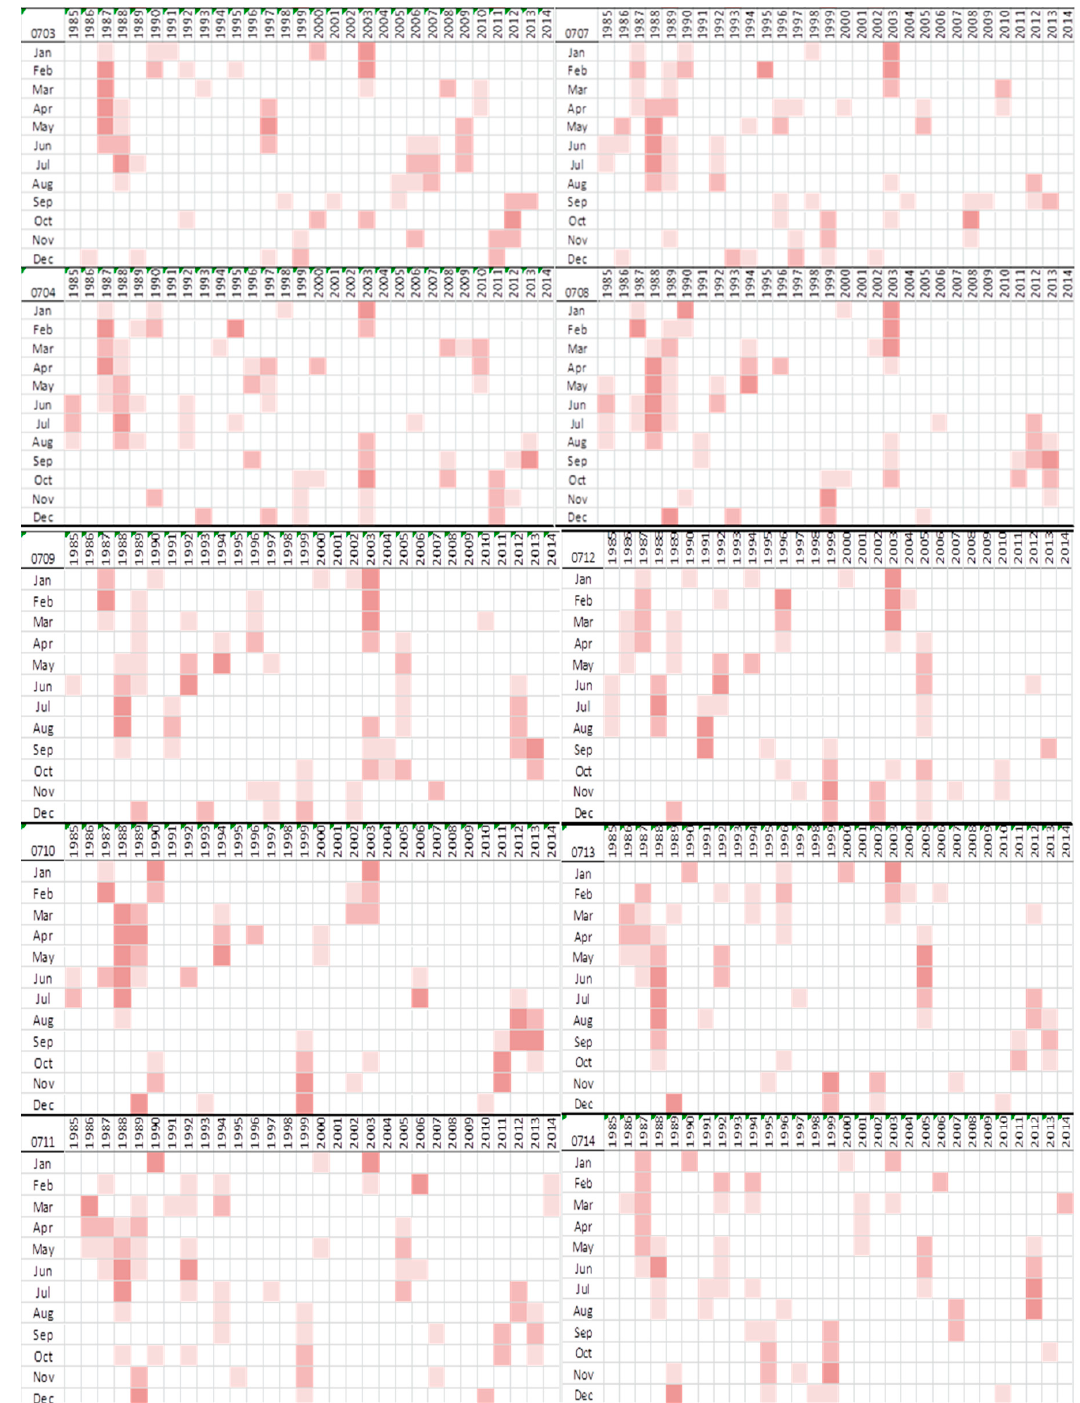
Figure A3. Outlook of the drought persistence for 14 HUC4 subbasins from 1985 to 2014 that was quantified by SPI3 .